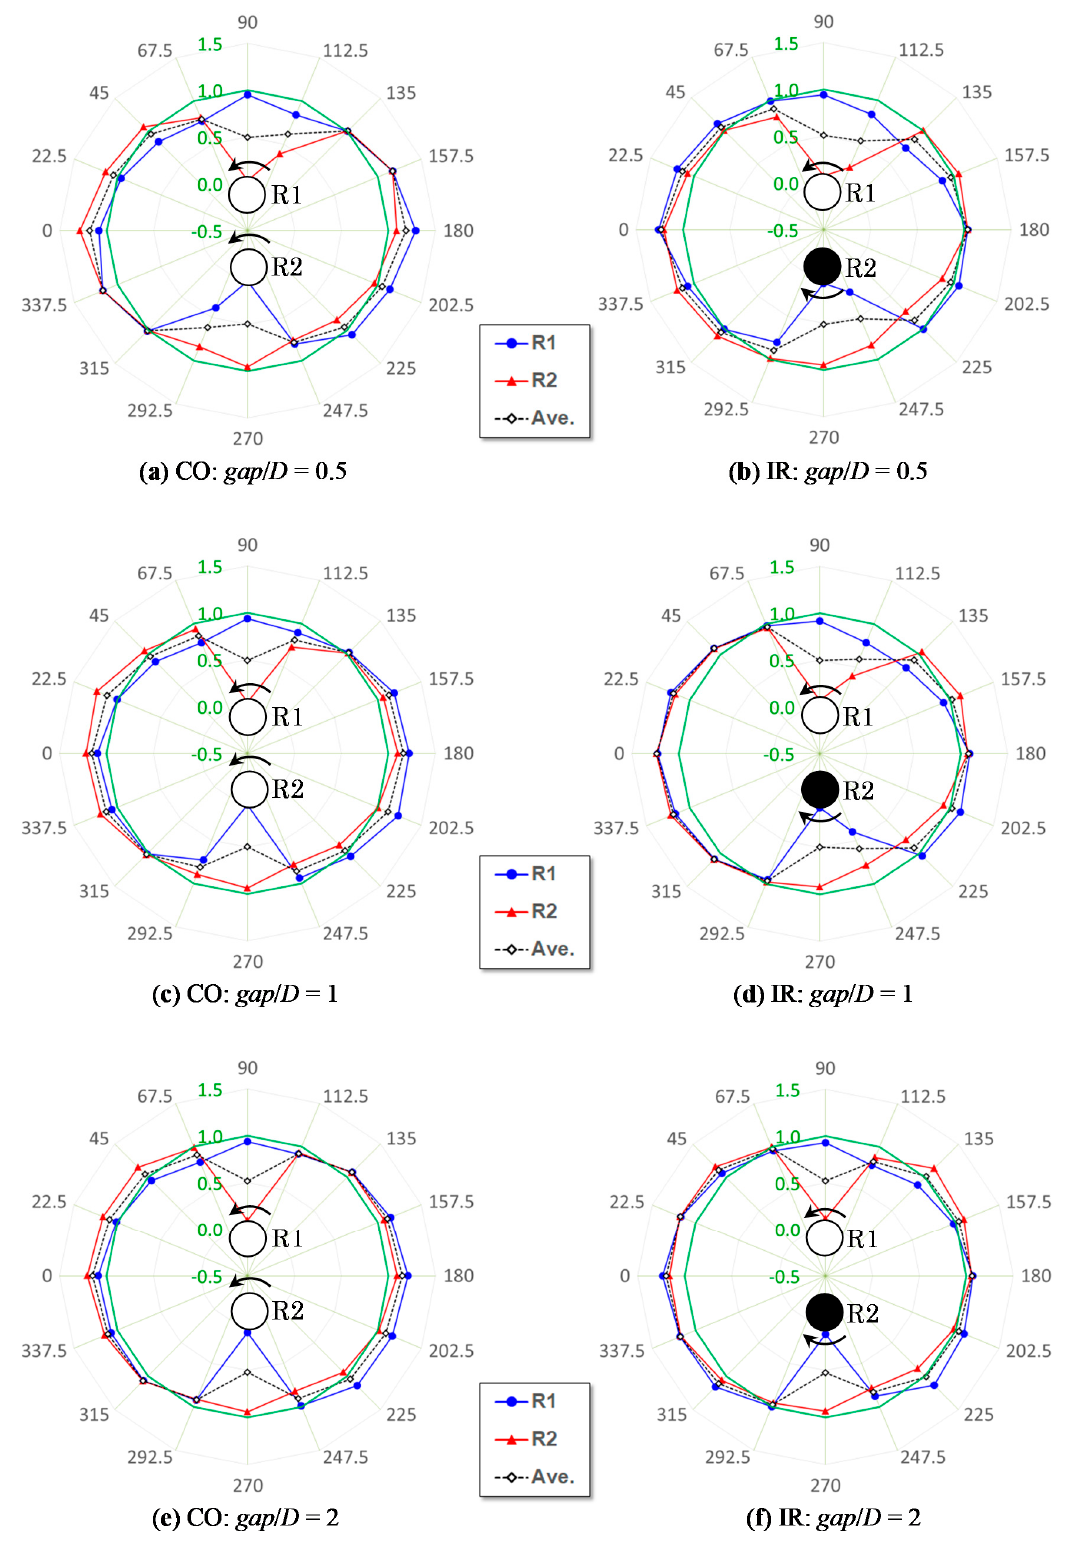
Figure 14. 16-wind-direction dependence of normalized power: ( a ) CO configuration, gap / D = 0.5; ( b ) IR configuration, gap / D = 0.5; ( c ) CO configuration, gap / D = 1; ( d ) IR configuration, gap / D = 1; ( e ) CO configuration, gap / D = 2; ( f ) IR configuration, gap / D = 2.